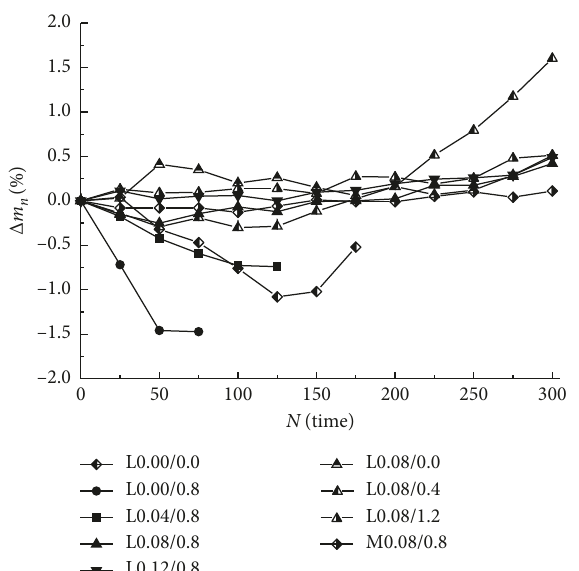
Figure 2: Changes of the mass loss rate with freezing-thawing cycles.